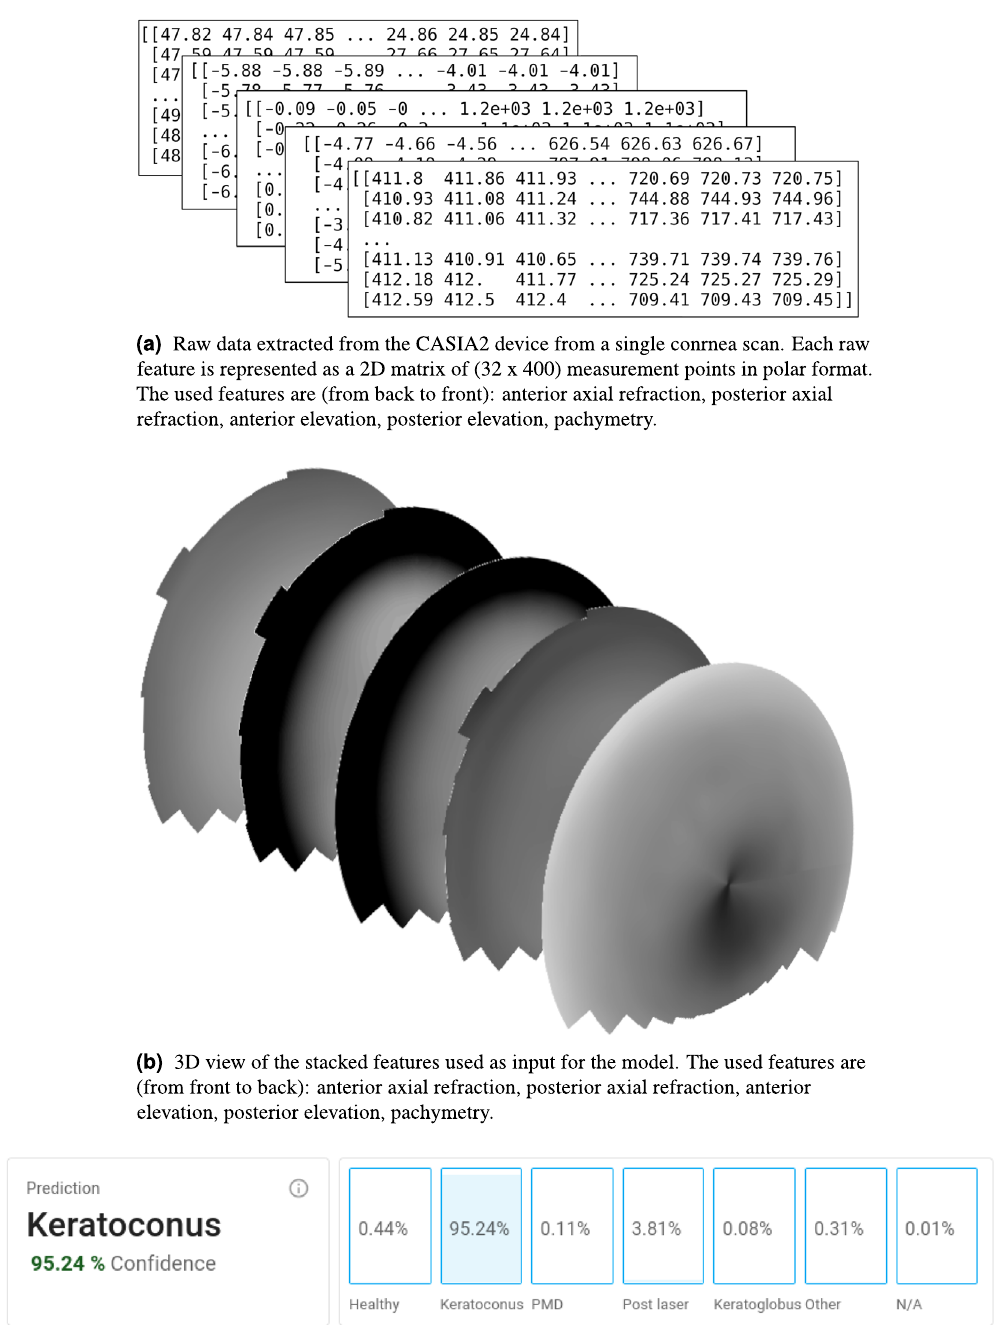
Figure 1. List of all the feature maps and how they are used as input for the CorNeXt model architecture. The topography maps are generated using matplotlib 20 based on the exported raw data from the CASIA2 device. ( a ) The raw data extracted from the CASIA2 device from a single cornea scan. ( b ) The features anterior and posterior axial refractive and elevation and pachymetry stacked as the five input channels for the CorNeXt model. ( c ) The softmax probability distribution of the models’ prediction over all classes.